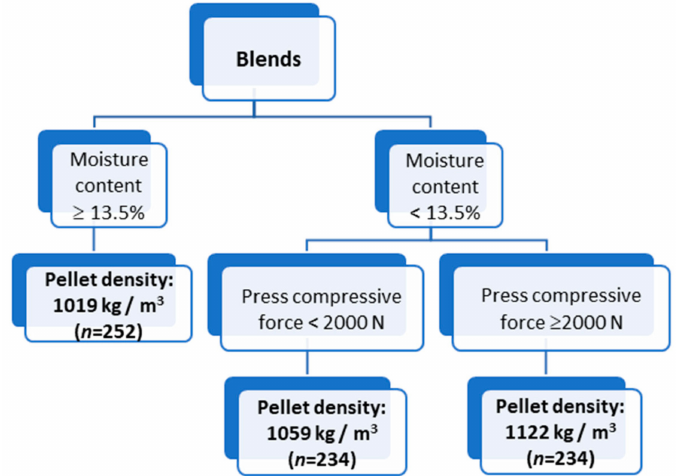
Figure 5. Regression tree of pellet density, with averages and number of observations (in